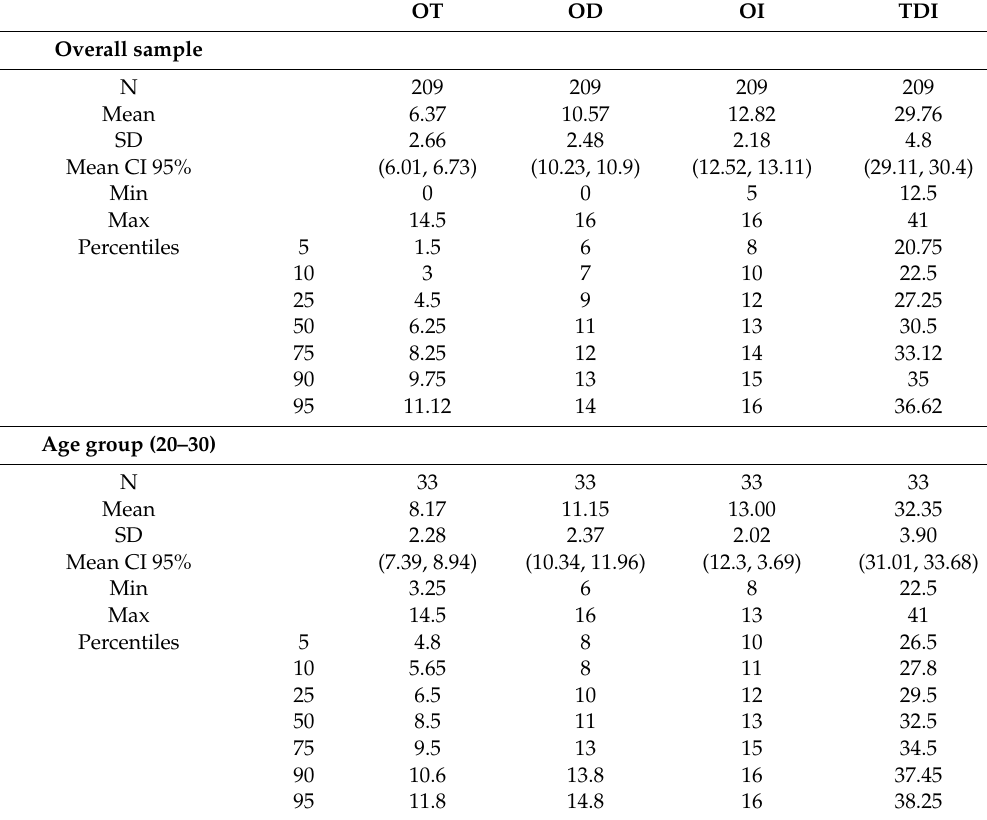
Table 2. Normative values per age group of OT, OD, OI, and